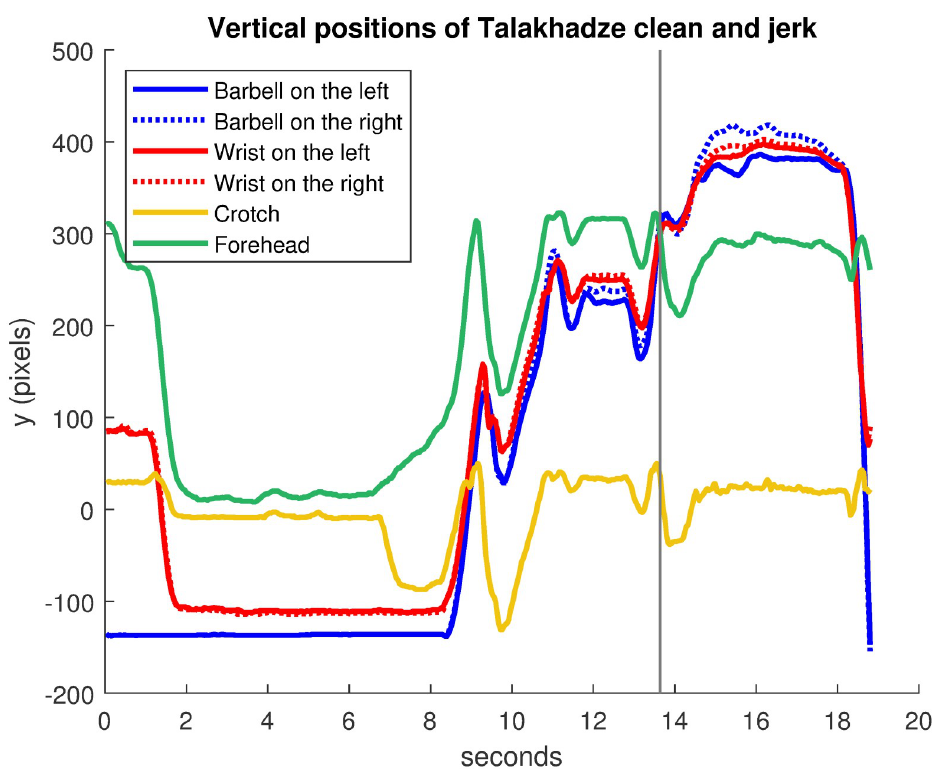
Fig 32. Vertical positions of Talakhadze clean and jerk. Curves of vertical positions (ordinate) of points of interest for Talakhadze and the barbell. The black vertical line at 13.64 seconds indicates when the barbell passes above the